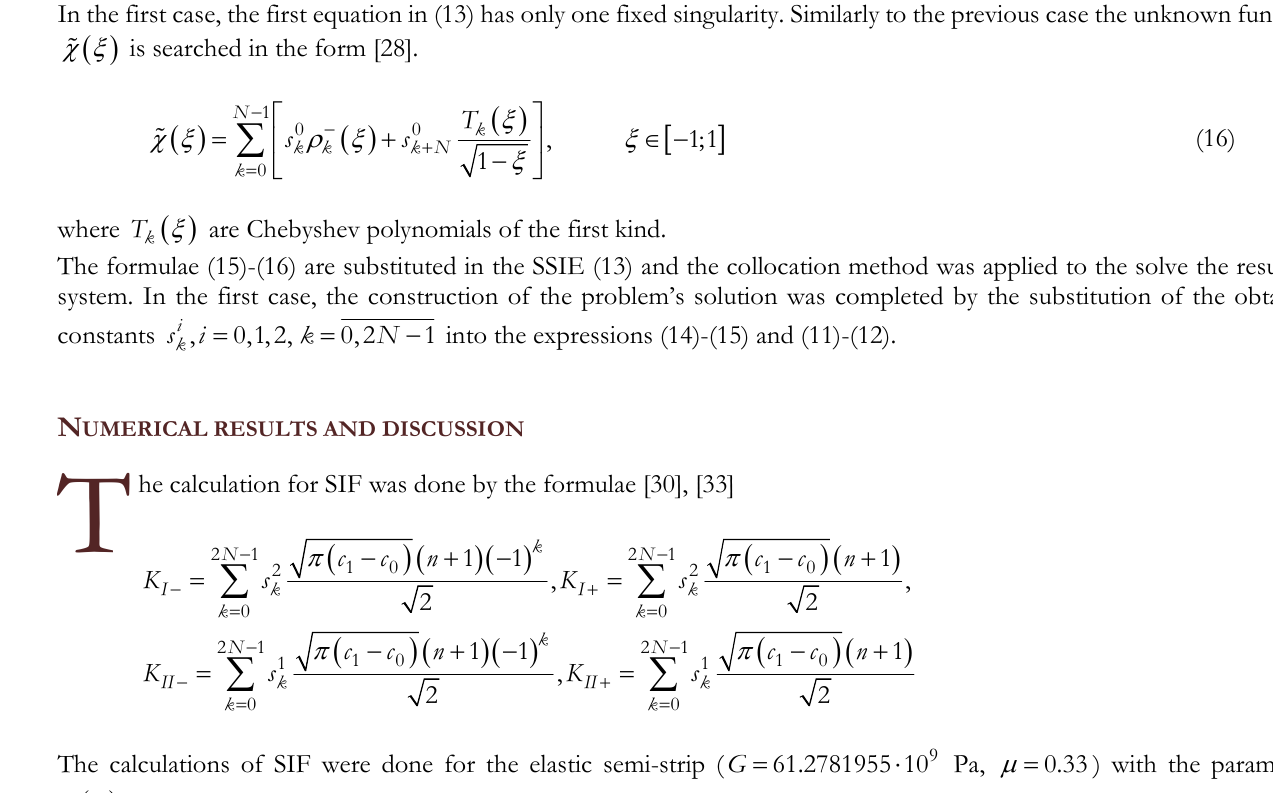
Figure 3: Second case: the changing of SIF ,